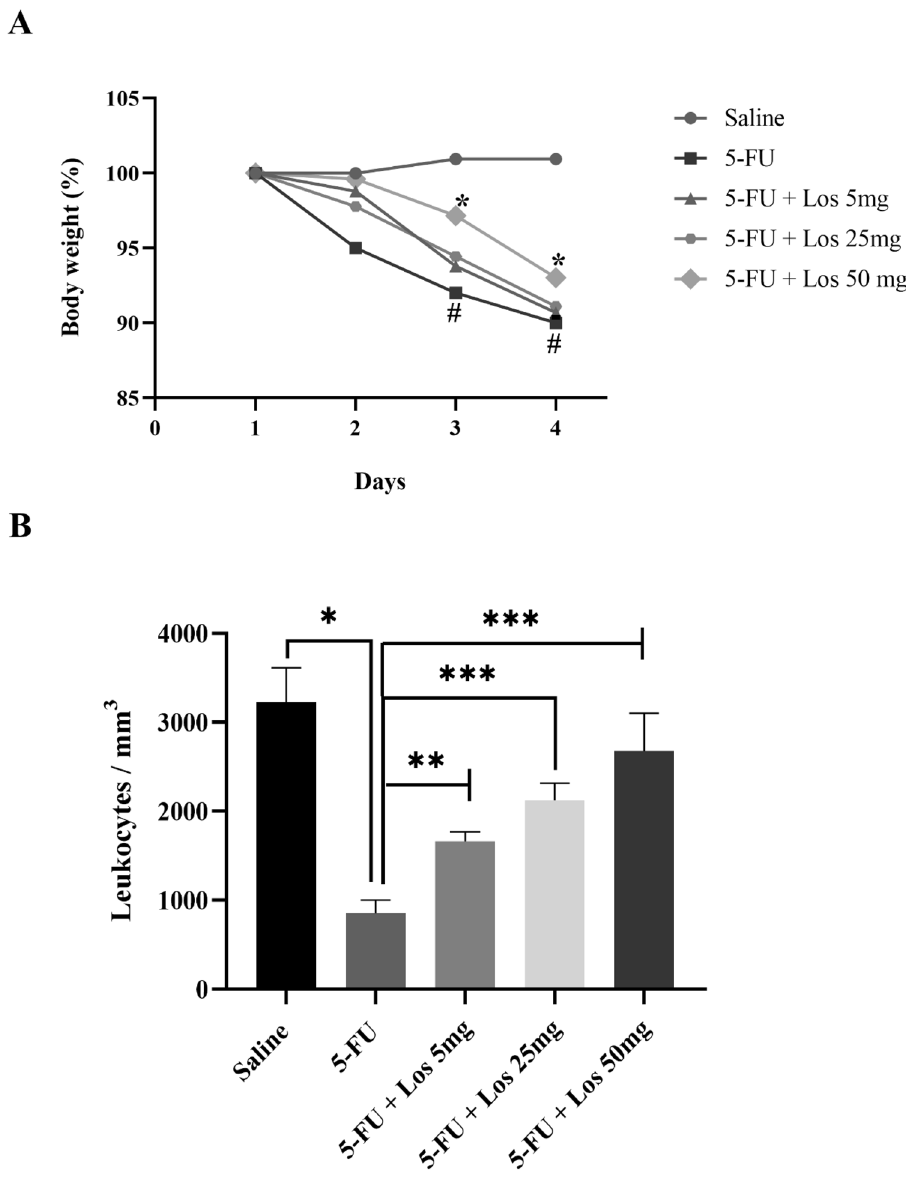
Figure 3. ( A ) Effect of losartan on weight loss and ( B ) total leukocyte count in mice with 5-FU-induced intestinal mucositis (IM). ( A ) Weight assessment is shown as a percentage. The bars represent the mean ± SEM (n = 5) in each group. # p < 0.01 versus Saline group; *p < 0.001 versus group 5-FU (Two-way ANOVA analysis of variance followed by the Tukey test). ( B ) Animals with IM, group 5-FU, reduced the number of leukocytes compared to the saline group (**p < 0.0001). LOS 50 mg/kg significantly increased the number of cells when compared to the 5-FU group. *p < 0.0001 vs. group 5-FU; **p < 0.001 versus 5-FU group and ***p < 0.05 versus 5-FU group. ANOVA one-way test followed by the Tukey